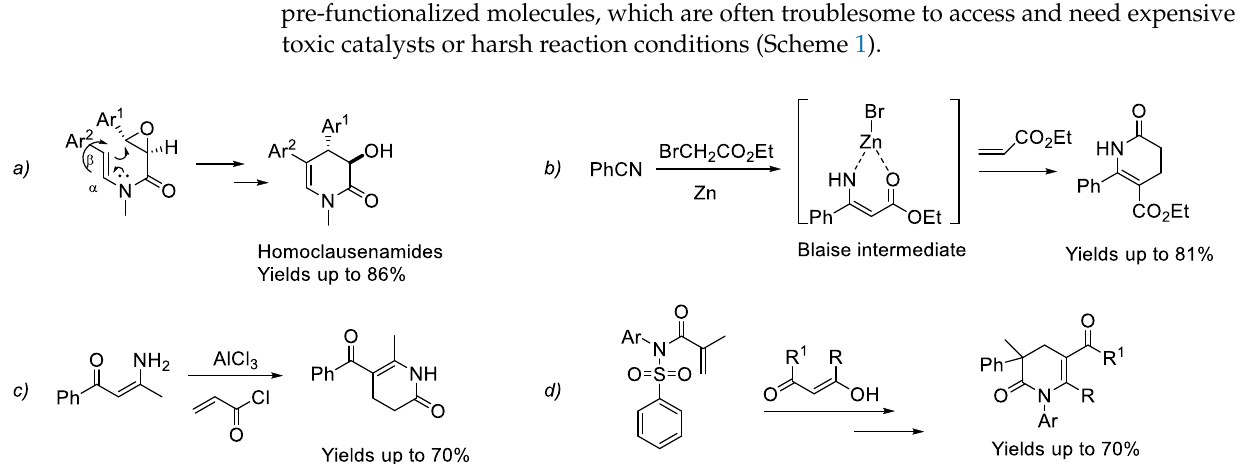
Figure 1. Natural and synthetic biologically active 3,4-dihydropyridinones.